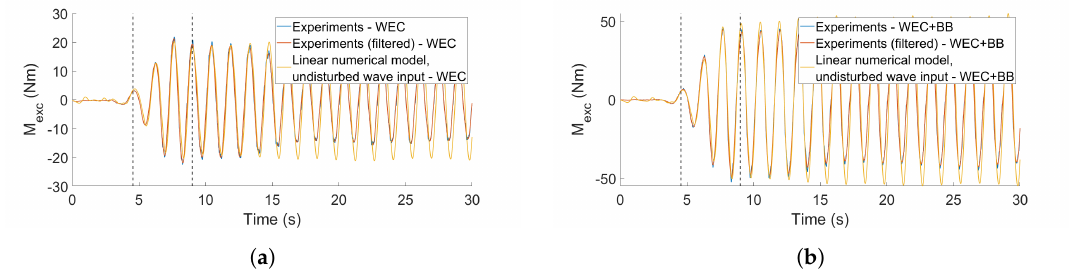
Figure 20. Wave excitation measured during fixed-WEC experiments under regular waves conditions. ( a ) Wave excitation measured during fixed-WEC experiments under regular waves for the setup of WEC Only. ( b ) Wave excitation measured during fixed-WEC experiments under regular waves for the setup of WEC with bottom box.